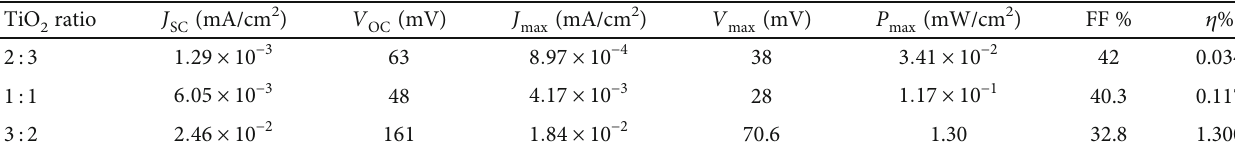
Table 1: DSSC data of the di ff erent volume ratios of TiO